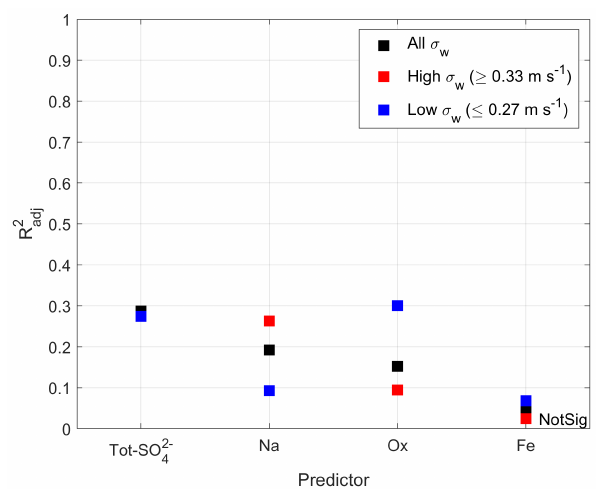
Figure 5. Effect of turbulence (quantified using σ w ) on the ability of a single species to predict N d . For NSS-SO 2 − low (blue) σ w data points overlap. NotSig represents not statistically significant according to the definition in Sect.